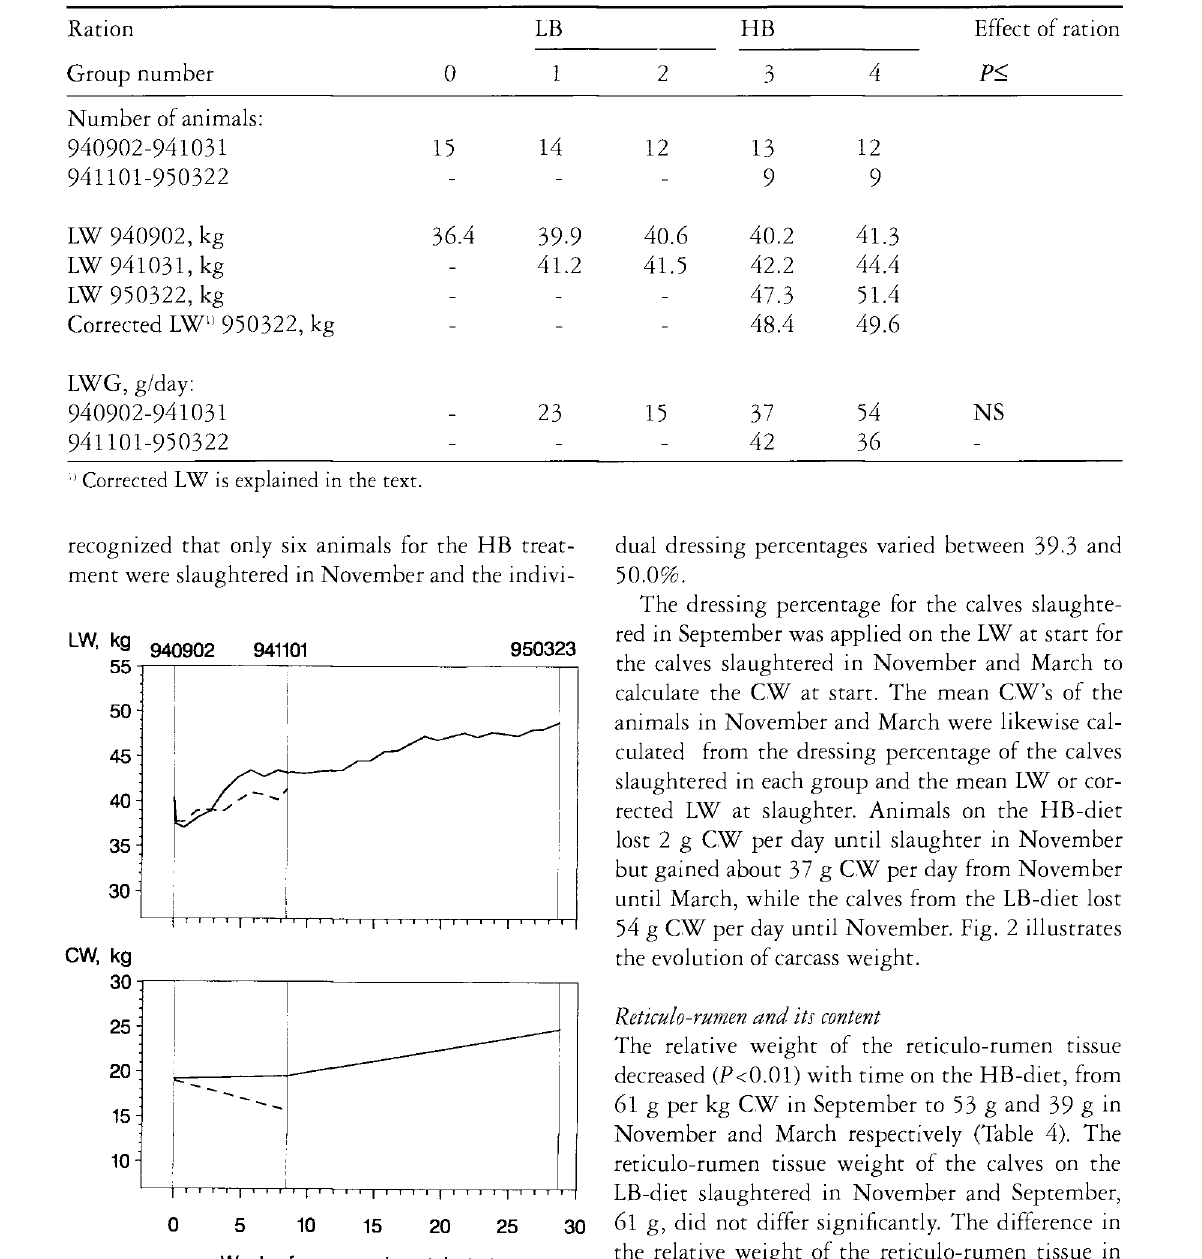
Table 3- Number of animals, live weight (LW) at start and slaughter and daily live weight gain (LWG) in groups of reindeer calves (cf. Table 2). Group number 0 was slaughtered at the start of the experiment.